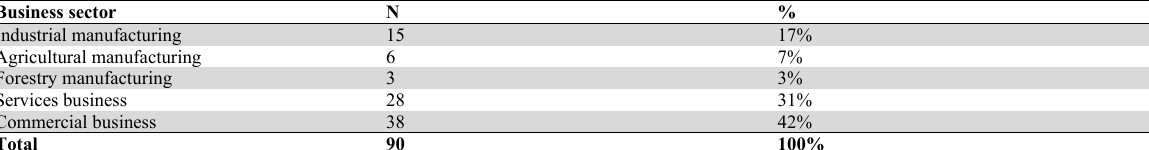
Respondents characteristics